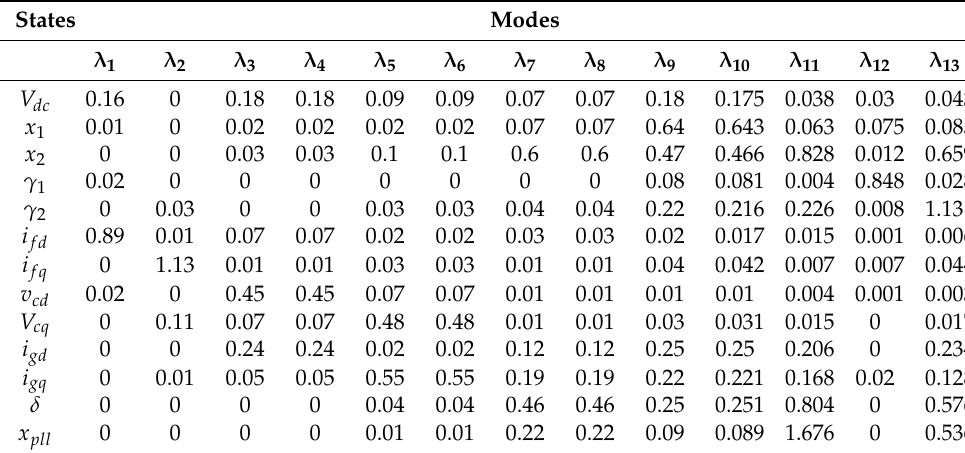
Table 3. Eigenvalues of the system and the states participation factor.